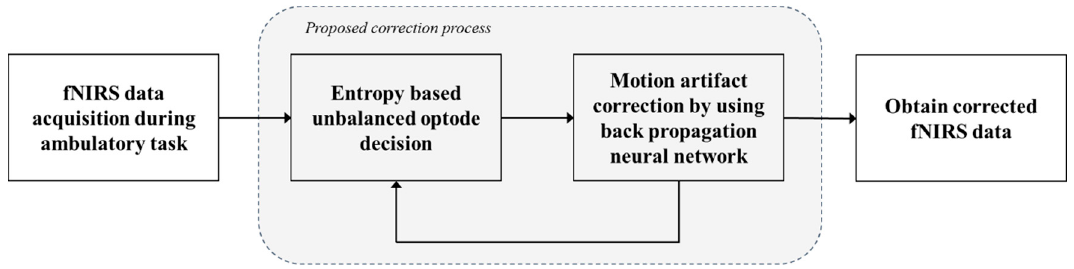
Figure 1. Block diagram of the proposed method.